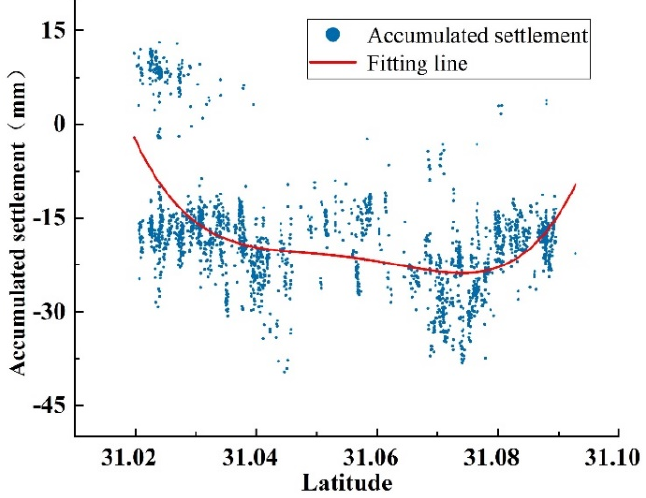
Figure 12. Cumulative subsidence of area A.